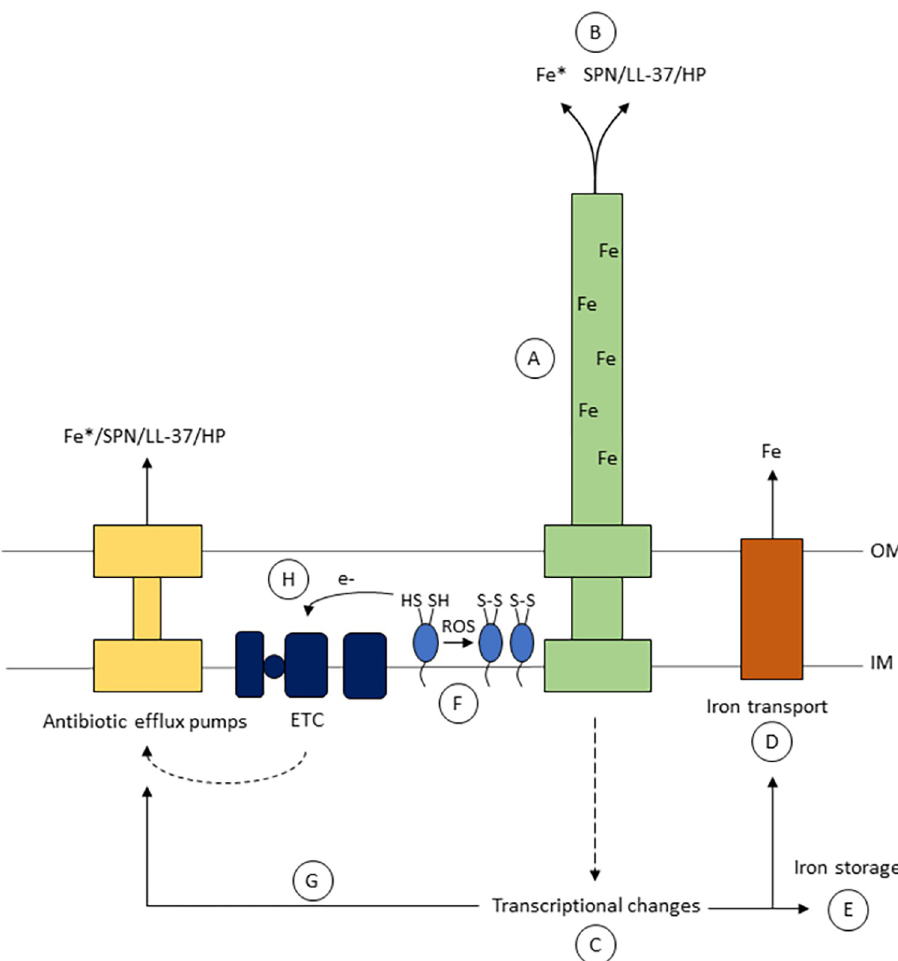
Fig 5. Possible mechanism underlying pilin-dependent iron homeostasis and resistance to hydrogen peroxide and LL-37. A. The pilus may bind to iron and/or B. transport hydrogen peroxide, LL-37, streptonigrin, and iron (Fe � ) which could be in an unbound state or complexed with another substrate. C. Piliation could affect the transcription of genes that are important for D. iron transport, E. storage, or G. antibiotic efflux. F. Reduced pilin can quench reactive oxygen species and form disulfide bonds. H. Electrons from reduced pilin subunits can affect the electron transport chain to influence the activity of antibiotic efflux pumps. These pumps may transport streptonigrin, LL-37, hydrogen peroxide, and/or iron in its free or complexed form. Abbreviations for electron transport chain (ETC), inner membrane (IM), and outer membrane (OM) are used.